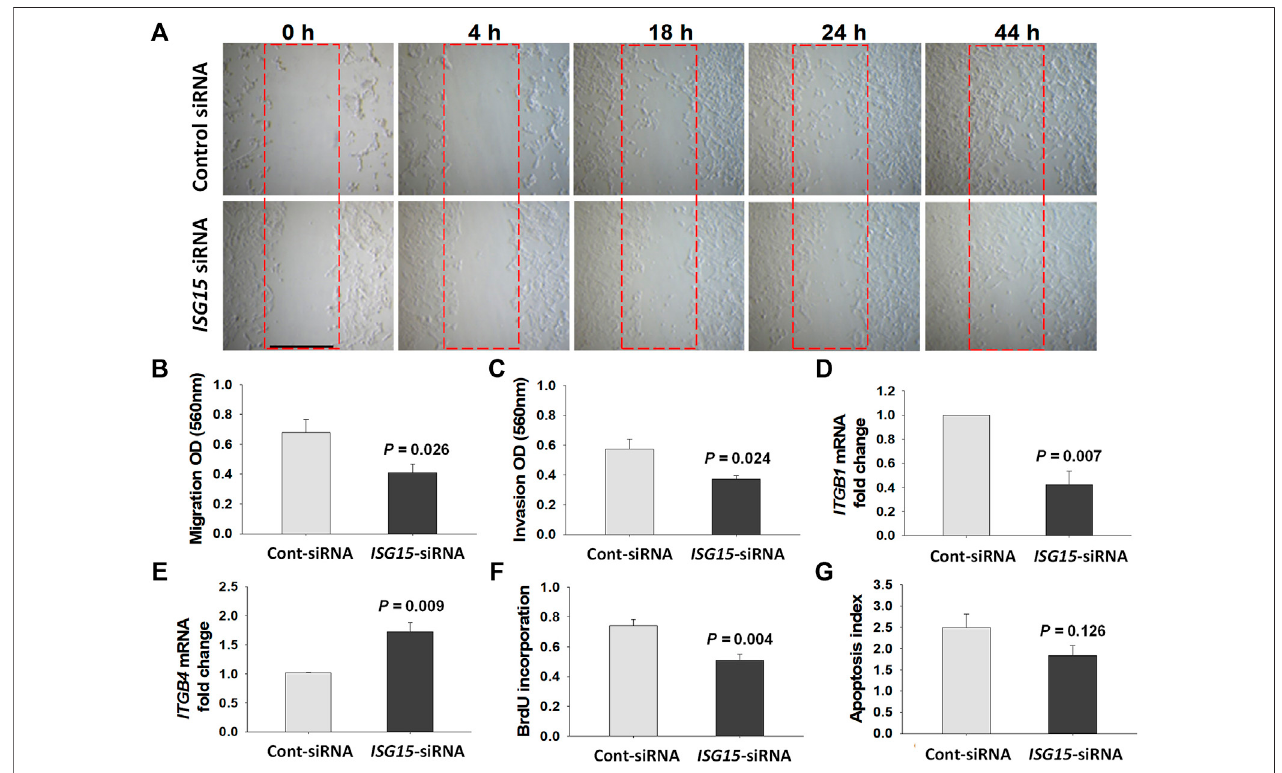
FIGURE6| ISG15 silencingreducestrophoblastmigration,invasionandproliferationcapacities. (A) Invitro woundhealing(0 – 44 h), (B) migration( n =5,48 h),and (C) invasion( n =5,60 h)capacities,mRNAlevelsof (D) ITGB1 ( n =3), (E) ITGB4 genes( n =3),aswellas (F) proliferation( n =5,48 h)and (G) apoptoticindex( n =6,48 h) are compared in control- vs. ISG15 -siRNA transfected HTR8/SVneo cells. Bars represent Mean ± SEM and compared by using t -test. Scale bar = 500 µm.